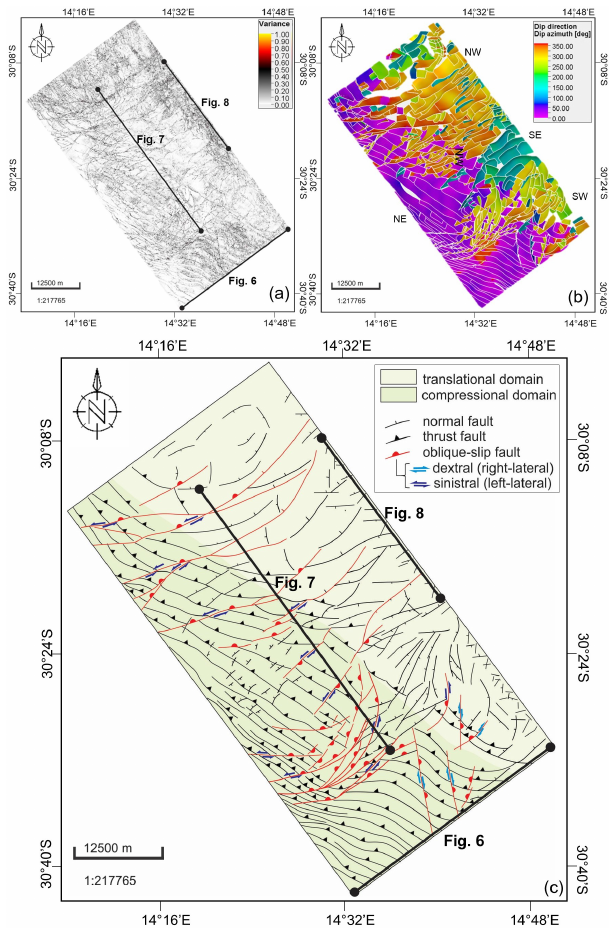
Figure 5. Structural framework showing the translational and com- pressional domains imaged in the study area. (a) Uninterpreted vari- ance time slice at − 3424ms (imaged within sequence B2 cover- ing depths approximately between − 3200 to − 5000m) showing the fault continuities. (b) The dip azimuth of various faults. (c) The in- terpretation of the structural framework in plan view using (a) and (b) including fault displacement characteristics observed in plan